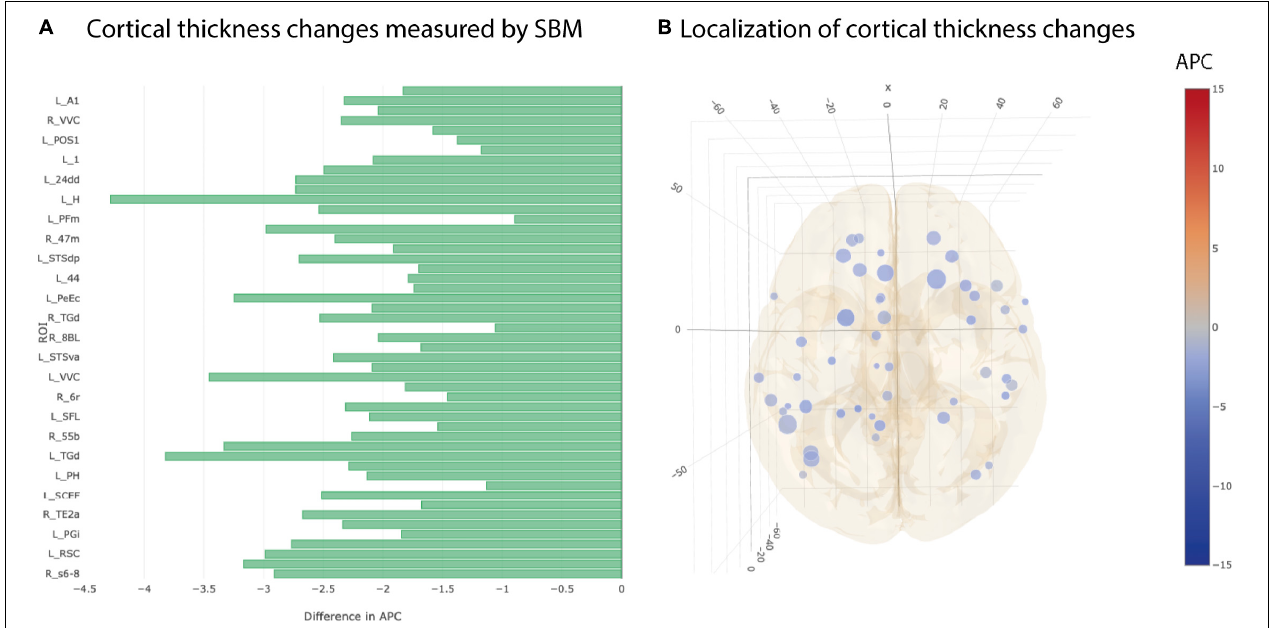
FIGURE 4 | Significant differences at individual testing level of annual percent changes in cortical thickness. (A) Horizontal bar plot of differences in group averaged cortical thickness changes (longitudinal SBM) between AD and CN groups. Bars to the left indicate a relatively stronger decrease in APC values in AD group than in CN group. (B) 3D lattice graph of ROIs with significant differences in volume changes shown in APC differences corresponding to panel (A) . Each circle is located at the center of mass of the corresponding ROI in MNI152 coordinate space. Color code indicates group extend and sign of APC differences whereas the diameter indicates absolute effect size. Brain hull was derived from a T1-weighted MR image in MNI152 standard